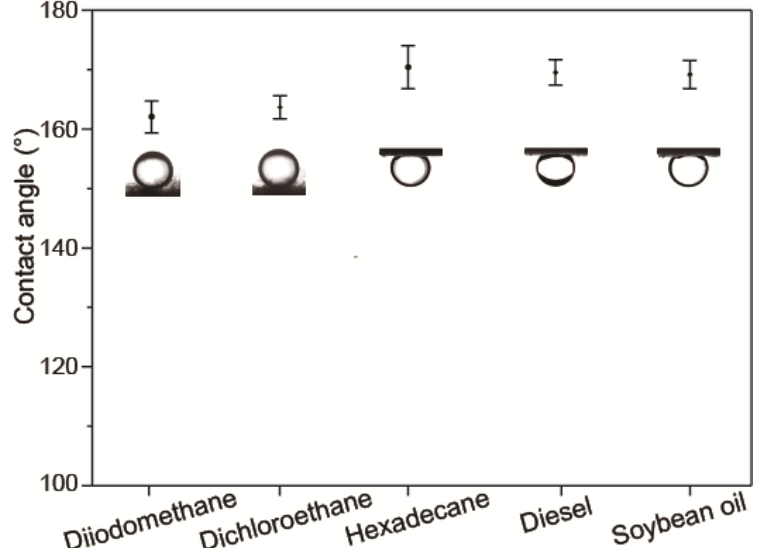
Figure 5. The underwater contact angles of various kinds of oils.